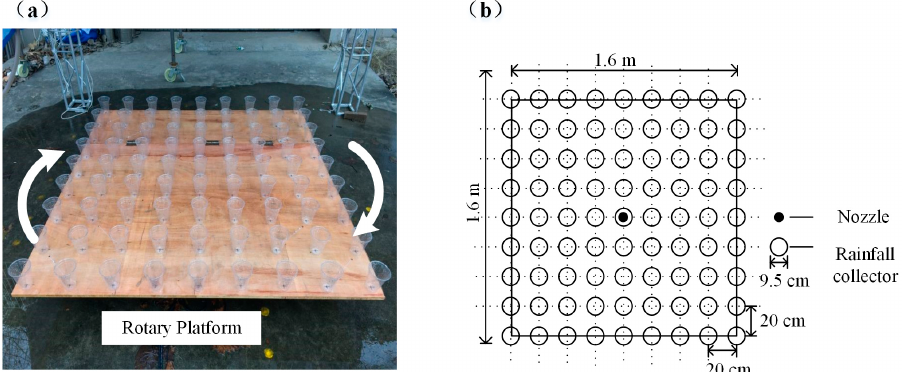
Figure 6. ( a ) Picture of the rotary platform; uniformity measurements were made with the measuring cups on an area measuring 2.56 m 2 , and ( b ) a schematic of the distribution of the measuring cups.